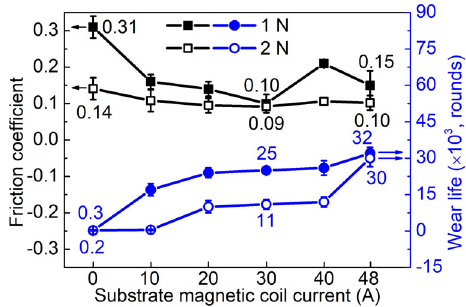
Fig. 5 Trends of friction coefficient and wear life with I s at loads of 1 and 2 N.